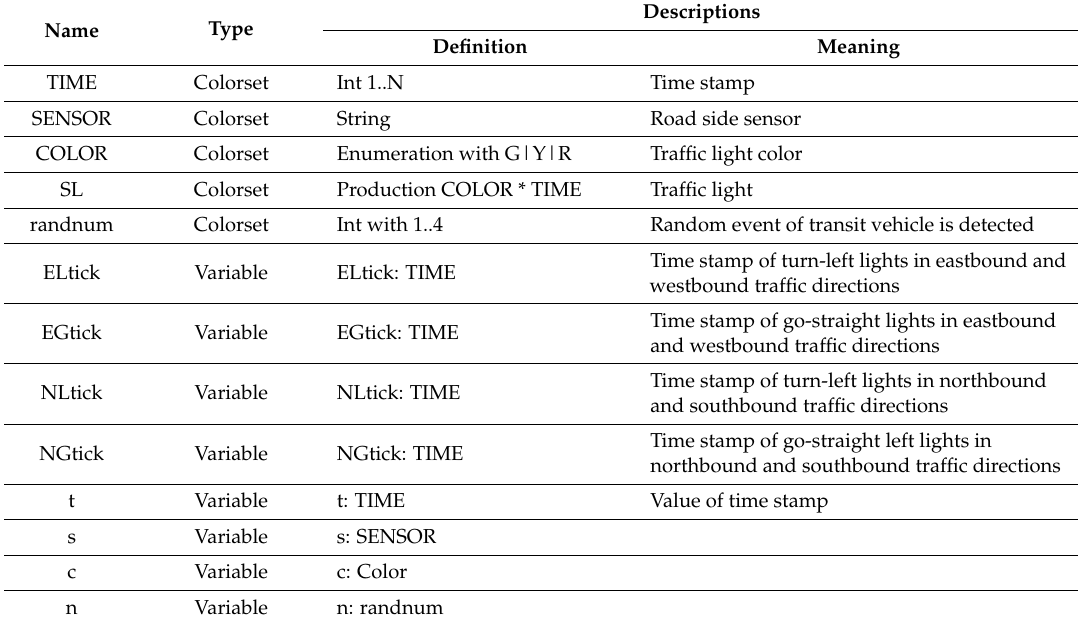
Table 1. Color specification in Figure